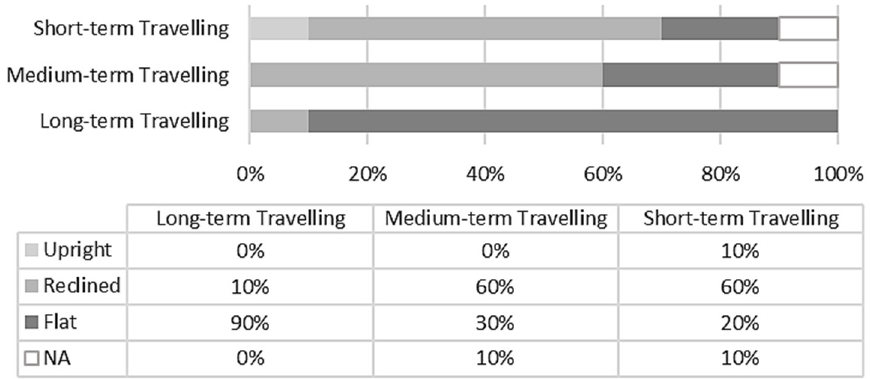
Figure 8. Relax levels from the question “How relaxed did you feel while experiencing the seat?” * symbol indicates a significant effect ( p < 0.05). The diamond shapes indicate the mean.